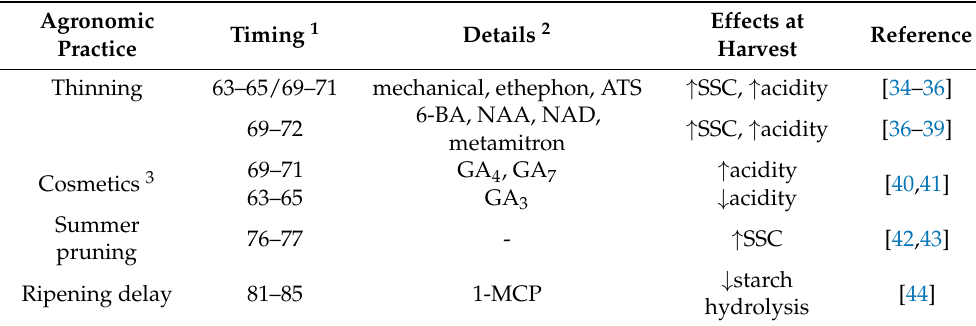
Table 1. Main agronomic practices that can indirectly affect the primary metabolite content of apples at